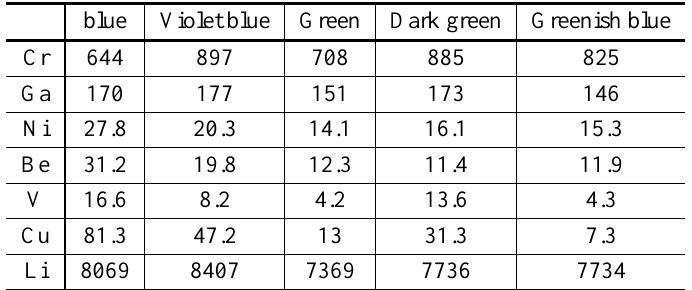
Minor element contents (ppm) obtained by ICP-AES of elbaites from the Alto Quixaba pegmatite, northeastern Brazil (A.C.M. Ferreira, unpublished